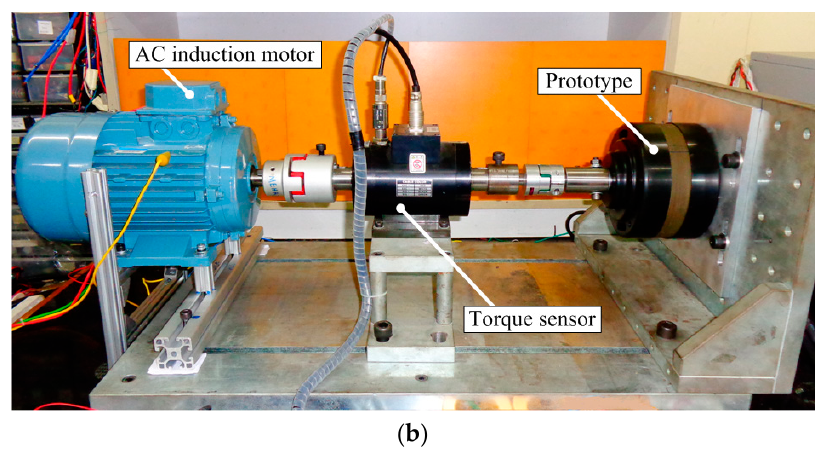
Figure 18. Experimental setup and validation: ( a ) Experimental configuration; ( b ) Test